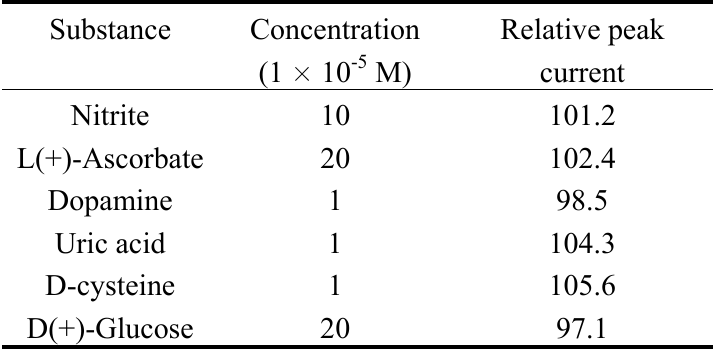
Table 2. Interference from other substance for NO